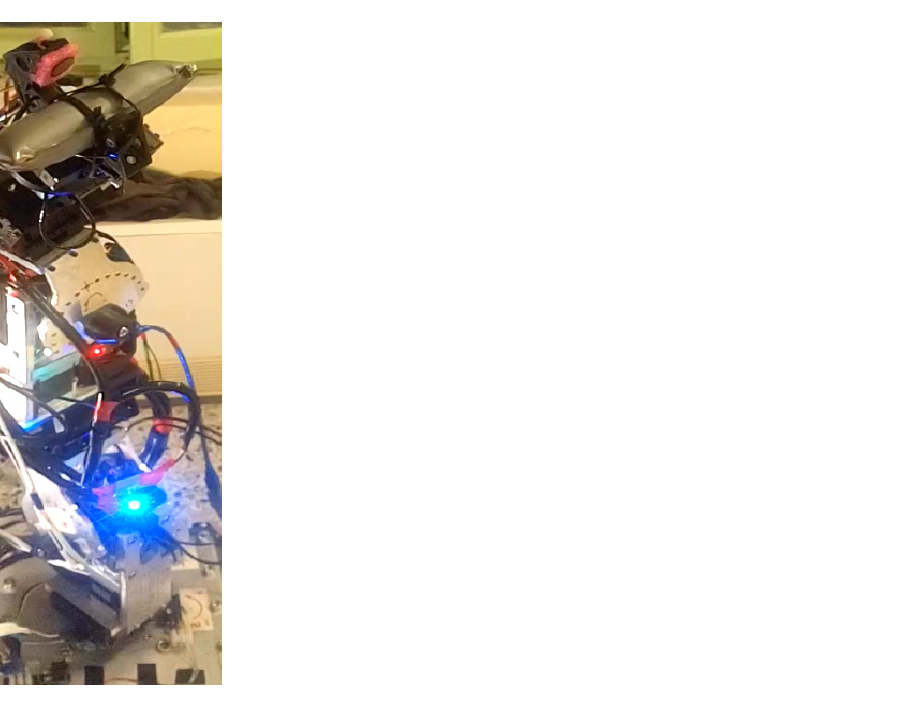
Figure 21. Optimal anatomy of the metamorphic manipulator derived under the effective mass measure for Task 3.